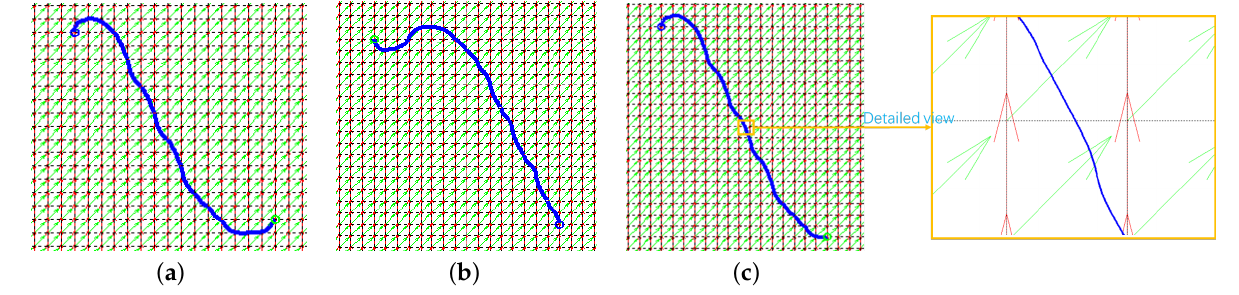
Figure 11. Motion planning for a USV in a free open-sea environment at different starting and ending points, considering wind and current disturbances. ( a ) Motion planning for a USV at the starting point (5, 24) and the ending point (20, 10). ( b ) Motion planning for a USV at the starting point (20, 10) and the ending point (4, 26). ( c ) Local details of USV motion planning at the starting point (5, 24) and the ending point (20, 5).